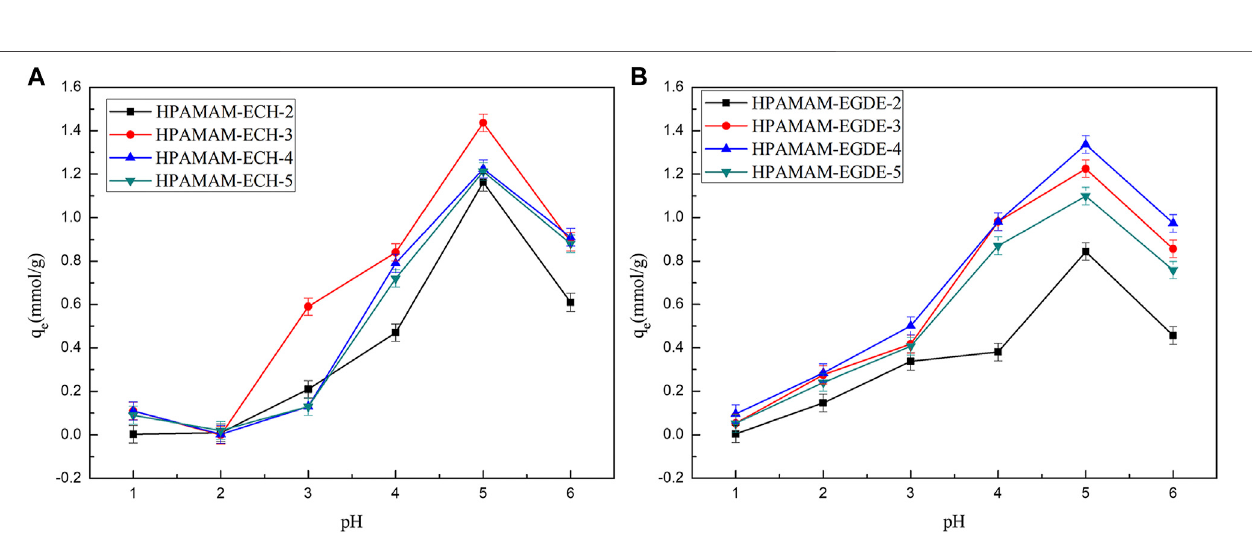
FIGURE 4 | Effect of pH on the adsorption for Hg(II): (A) HPAMAM-ECH samples and (B) HPAMAM-EGDE samples.